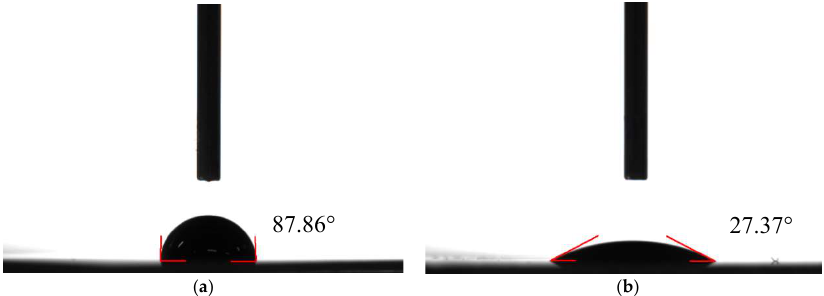
Figure 5. Contact angle images of PEDOT:PSS aqueous solution drops on the ( a ) H-terminated and ( b ) SiO x -terminated silicon substrates. Table 2. Contact angles of PEDOT:PSS drops on the H-terminated and oxygen-terminated silicon substrates.